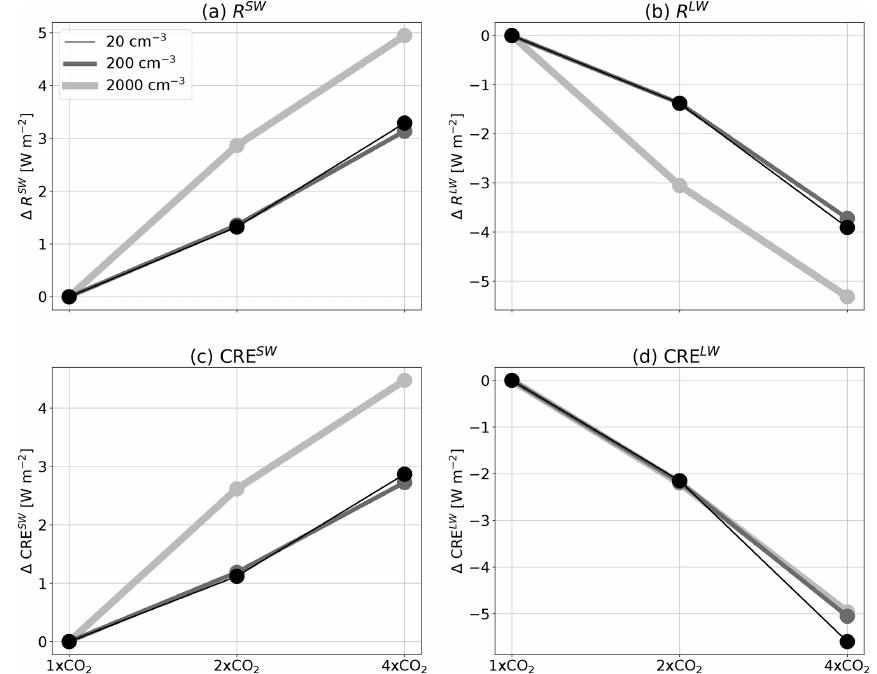
Figure 3. The change in the net top-of-atmosphere energy gain ( R ) in the short wave (a) and in the long wave (b) and the change in the cloud radiative effect (CRE) in the short wave (c) and in the long wave (d) , due to a change in the CO 2 concentration (compared to the 1 × CO 2 case of each aerosol concentration), for the different aerosol concentrations (the different curves).